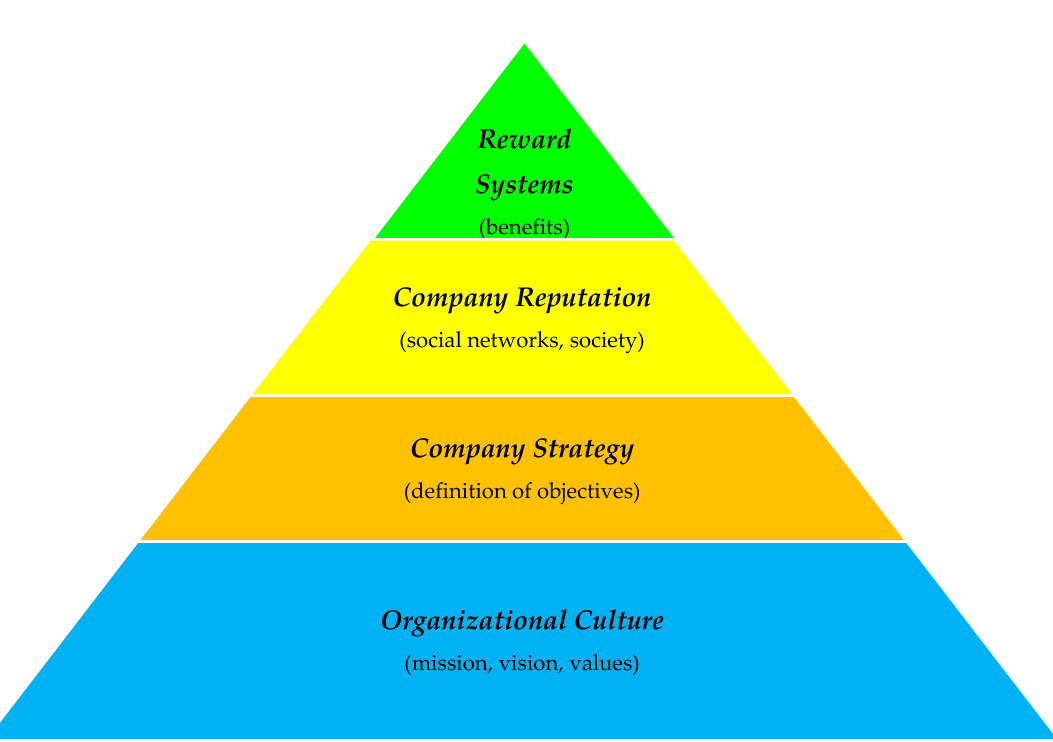
Figure 1. Employer branding model applied to small and medium enterprises